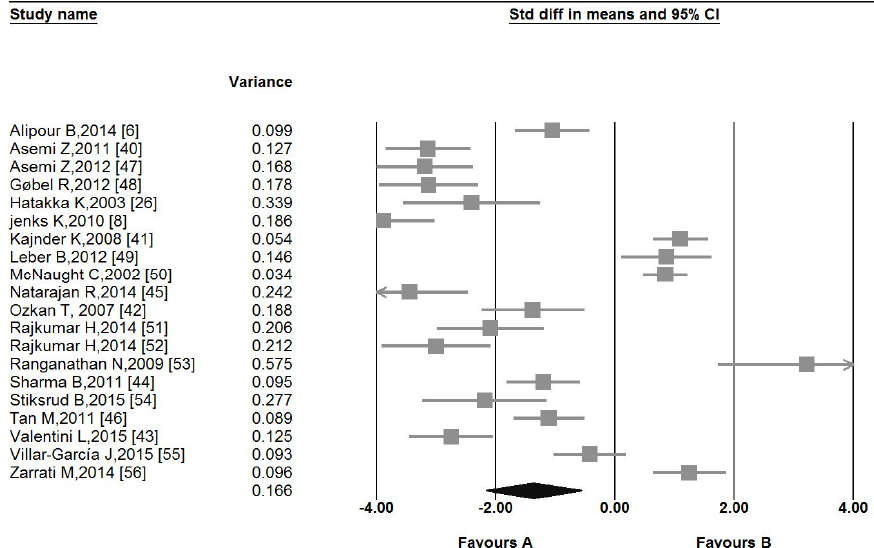
Figure 2. Forest plot displaying weighted mean difference and 95% confidence intervals for the impact of probiotic administration on C ‐ reactive protein (CRP) levels. of probiotic administration on C-reactive protein (CRP)